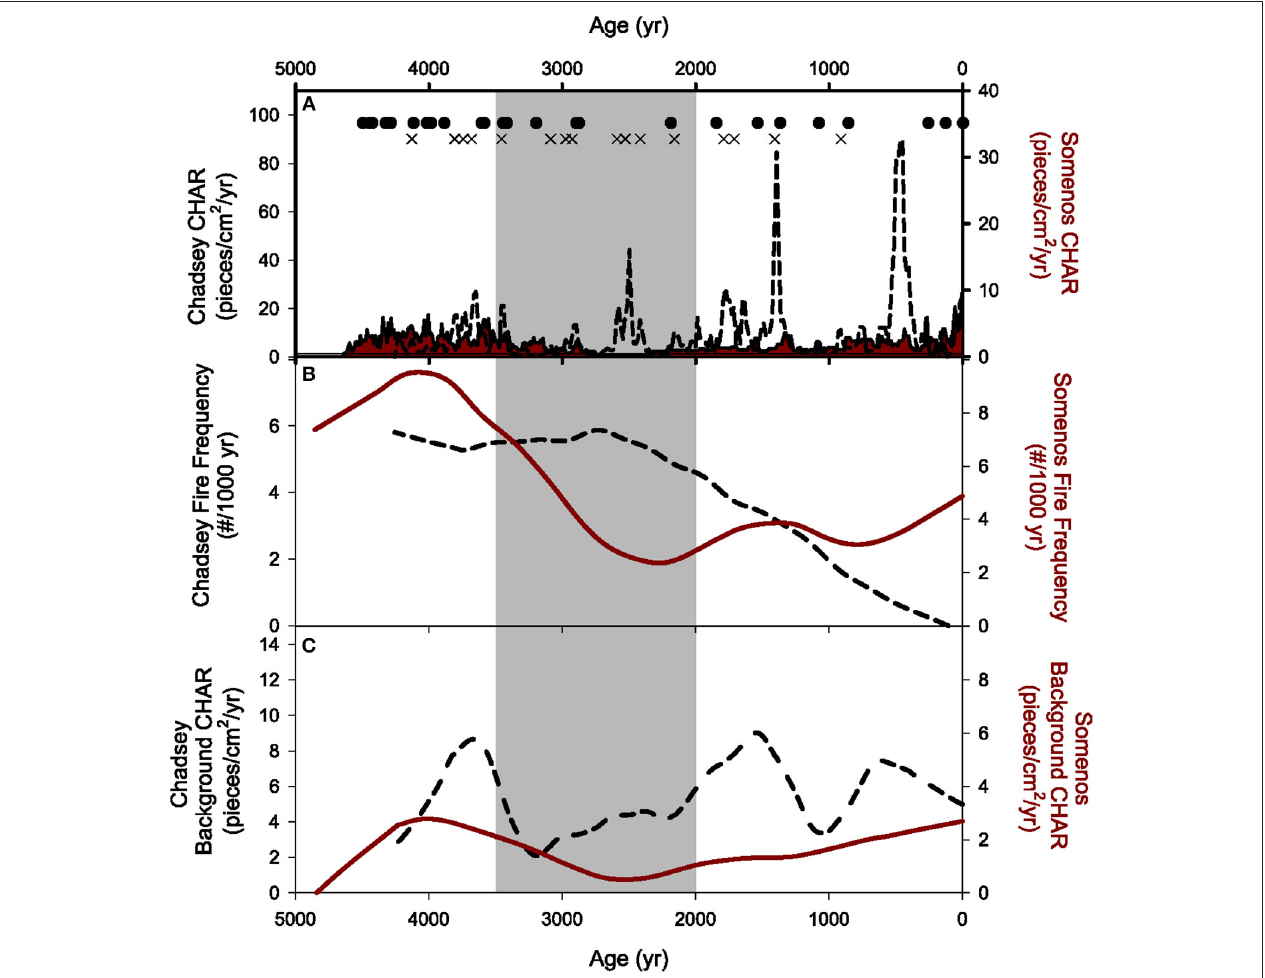
FIGURE 3 | Fire history characteristics of Somenos and Chadsey Lakes over the last ∼ 5,000 years. (A) CHAR records from Somenos (red shaded area) and Chadsey (dashed line). Fire episodes indicated with X’s (Somenos) and dots (Chadsey). (B) Fire frequency records for Somenos (solid line) and Chadsey (dashed line). (C) Background CHAR for Somenos (solid line) and Chadsey (dashed line). In all panels, gray shaded area represents Zone 2 (3,500–2,000 cal yr BP).